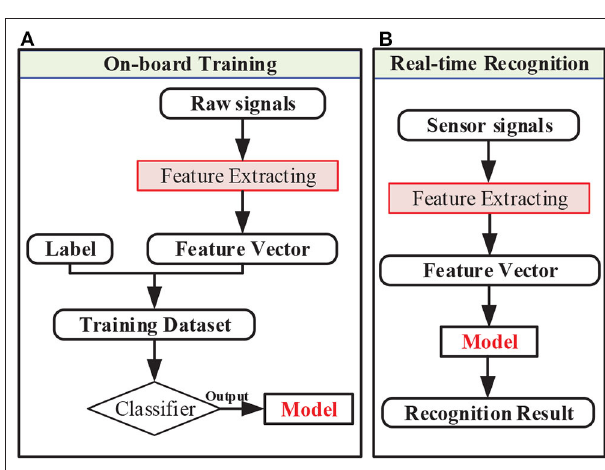
FIGURE 4 | The procedures of signal processing for (A) on-board training and (B) real-time recognition.